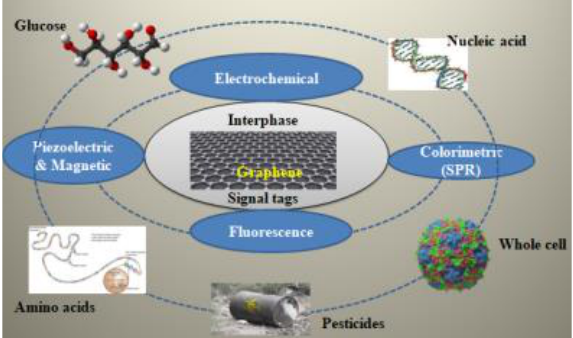
Figure 4. Graphene-based sensing techniques for different analytes.